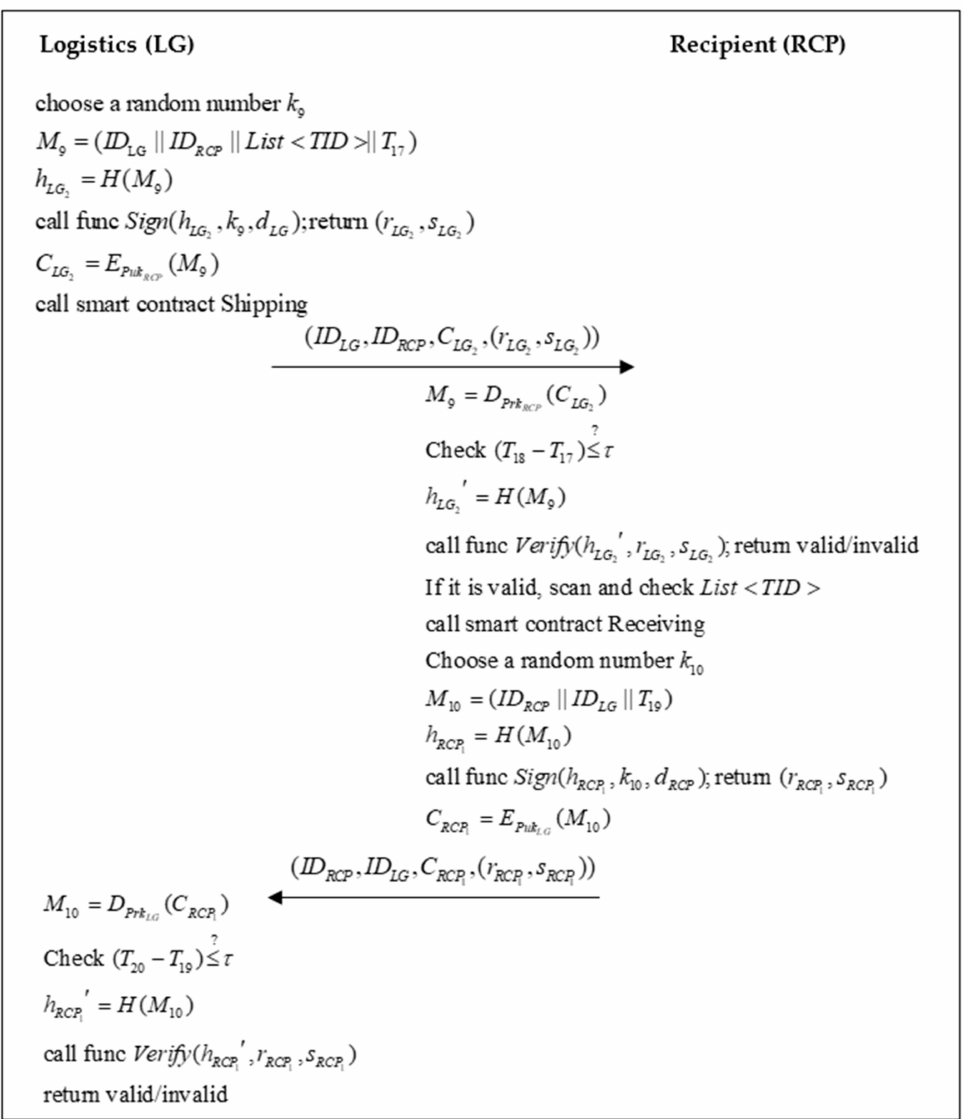
Figure 10. The flowchart of the logistics phase from logistics to the